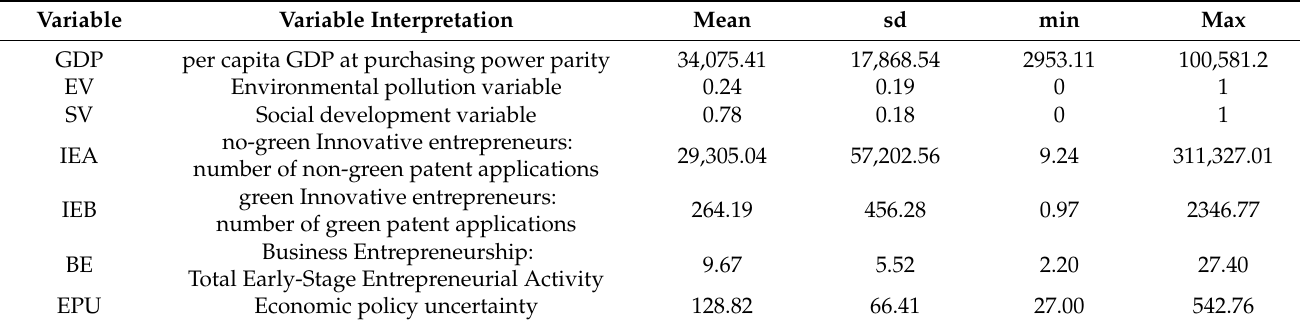
Table 1. Descriptive statistical analysis of variables.